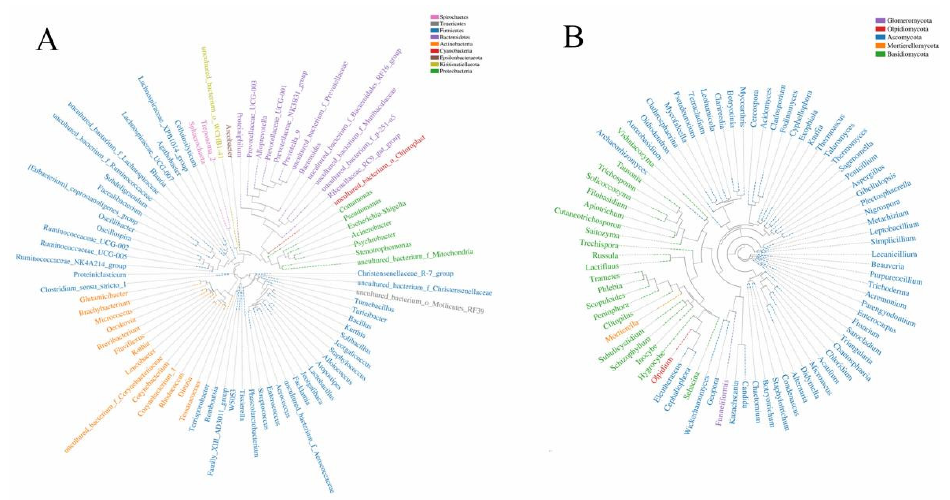
Figure 5. The evolutionary tree of bacterial and fungal species in PM 2.5 . ( A ) The evolutionary tree of bacterial species. ( B ) The evolutionary tree of fungal species. Note: The same color represents the same phylum. Each branch in the evolutionary tree represents a species, and the length of the branch represents the evolutionary distance between the two species, for example, the degree of species difference.